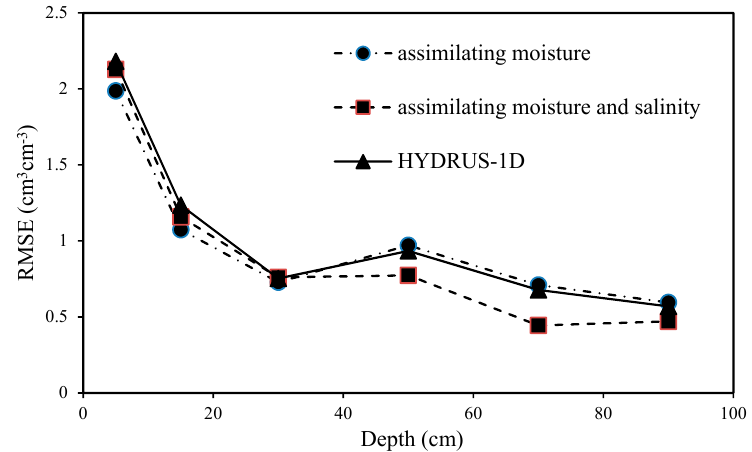
Figure 8. Comparison of the RMSE values for different depths in HYDRUS-1D, for the assimilation of only soil moisture and the assimilation of soil moisture and salinity.